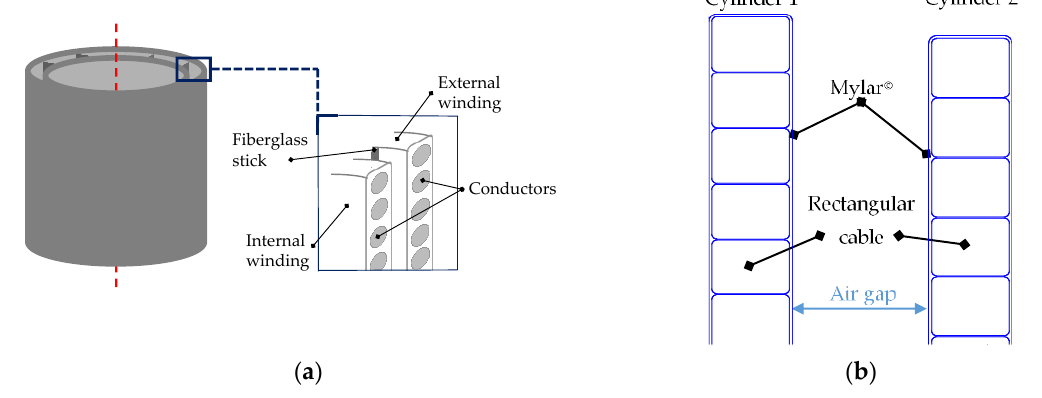
Figure 10. CAD design of the reactor: ( a ) 3D design of the dry-type air-core reactor; ( b ) axisymmetric 2D model of the dry-type air-core reactor.